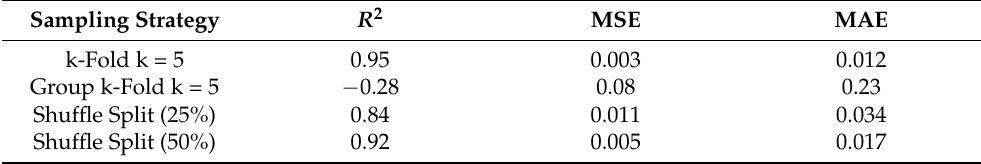
Table 9. The impact of data set splitting on prediction accuracy for Decision Tree Regression. Sampling